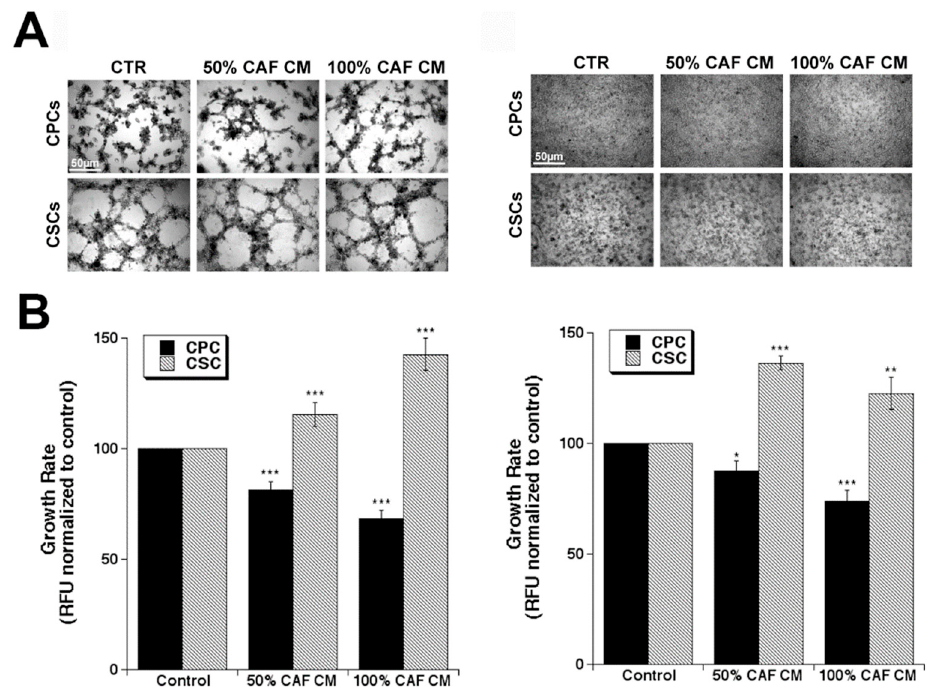
Figure 1. CAF conditioned medium inhibits CPC viability and stimulates CSC viability on both ECM compositions. ( A ) Representative microscopic images of growth morphology of Panc1 CPCs and their derived CSCs after 5 days of culture on organotypic cultures composed of 90% Matrigel:10% Collagen I (left panel) and 20% Matrigel: 80% Collagen I (right panel). Scale bar represents 50 µm for all images. ( B ) CPC and CSC viability in organotypic cultures of 90% Matrigel:10% Collagen I (left panel) and 20% Matrigel:80% Collagen I (right panel) were calculated from Resazurin reduction assays and are normalized to the control as 100 as described in Materials and Methods. Data are mean ± SEM, n = 5, * p < 0.05, ** p < 0.01, *** p < 0.001 to the control of each cell type on each matrix.